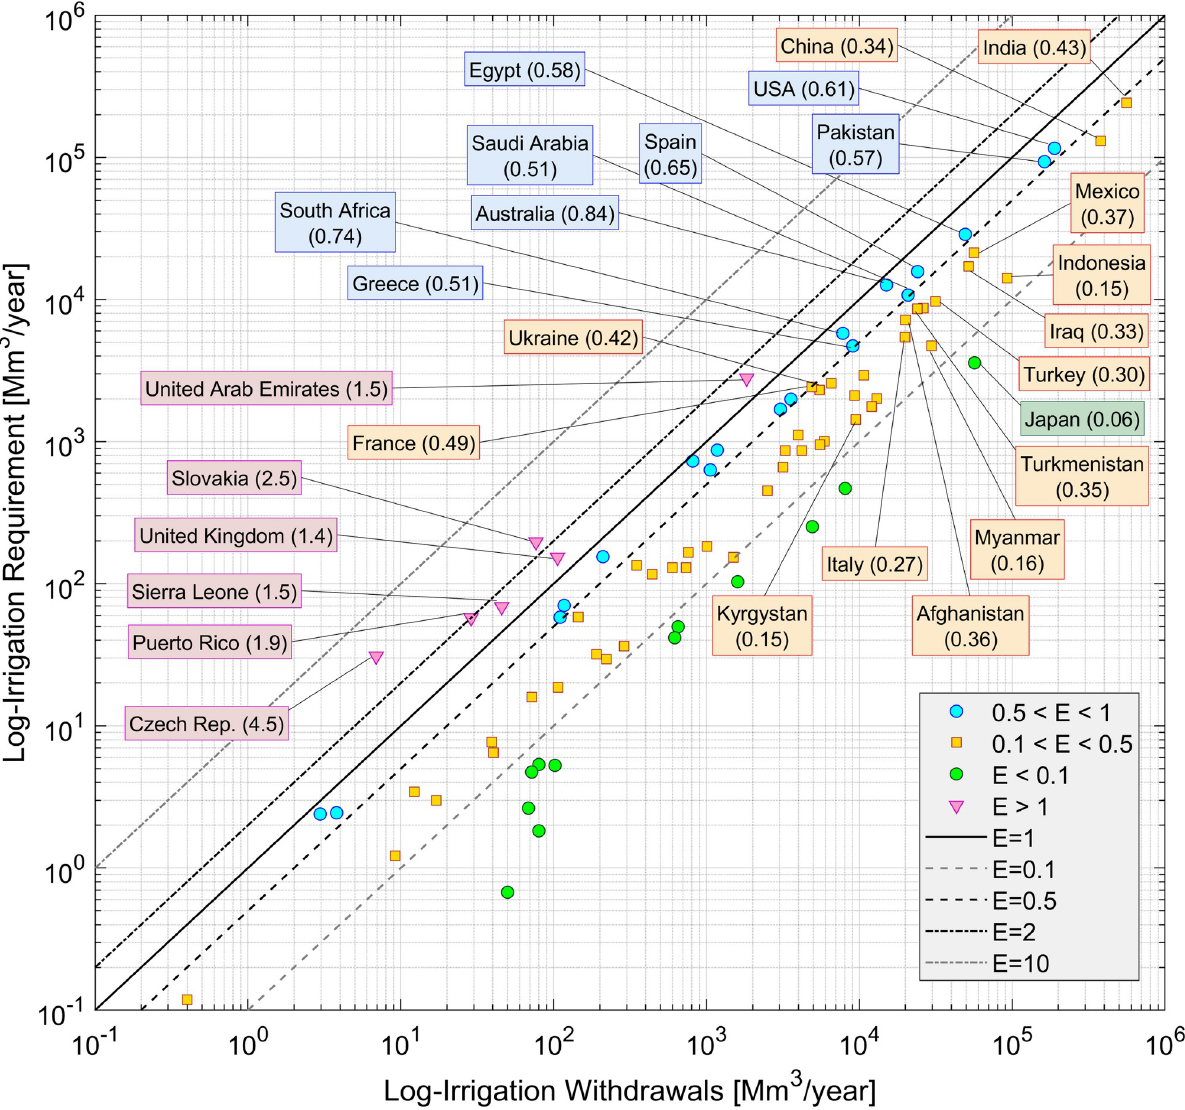
Fig 7. Comparison of national irrigation requirements and withdrawals and aggregation by classes of national efficiency. Blue circles, red crosses and green squares are countries where I < W , grouped by classes of E . Purple triangles are countries for which the model estimates I higher that actual W . The bold continuous line indicated the condition of I = W ; classes of efficiencies lower than 1 are limited by dashed lines, while the two dotted lines delimit classes of efficiencies higher than 1. For E < 1, the labeled countries have at least 10 6 ha of areas equipped for